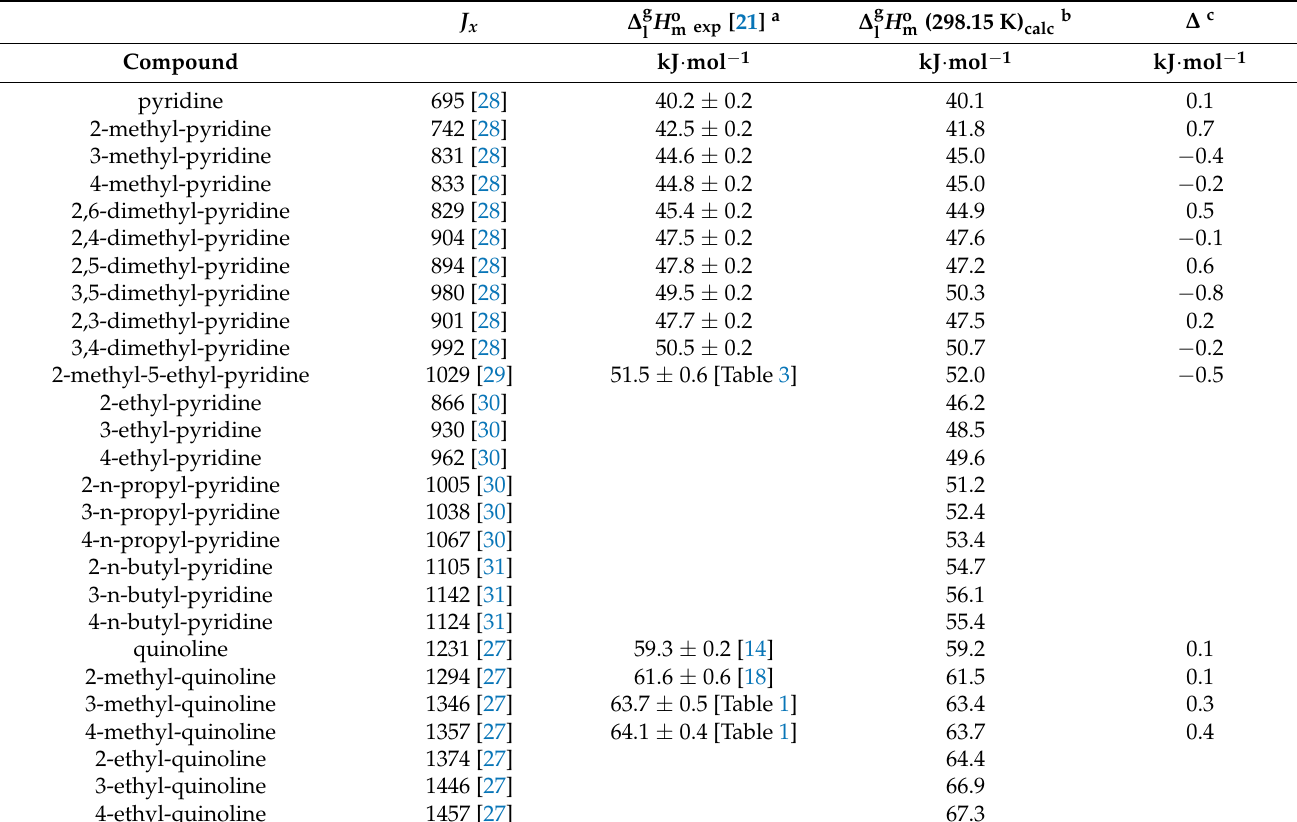
Table 5. Correlation of vaporization enthalpies ∆ g there is no copyright issue indices on non-polar